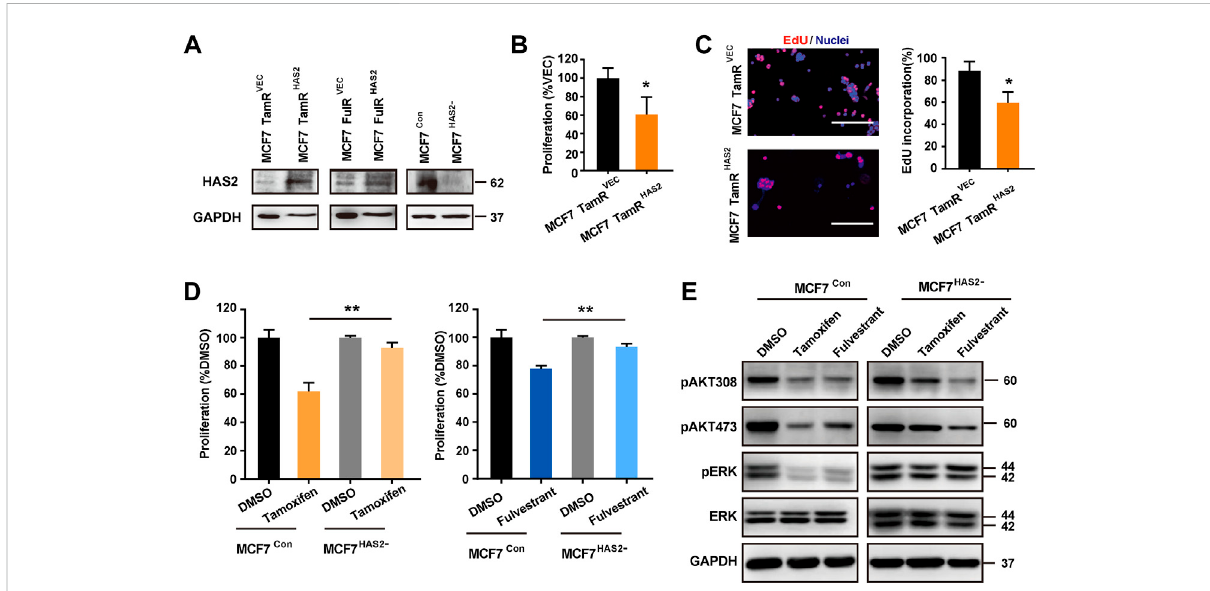
FIGURE 2 HAS2 regulated the sensitivity of ER + breast cancer cells to antiestrogens. (A) Immunoblotting analysis of HAS2 expression in endocrine- resistant MCF7 cells (MCF7 TamR and MCF7 FulR) with HAS2 overexpression and naïve MCF7 cells with HAS2 knockout. (B) The proliferation of MCF7 TamR cells with (MCF7 TamR HAS2 ) or without (MCF7 TamR Vec ) HAS2 overexpression was determined by CCK8 assay after being treated with tamoxifen(1 μ M)for3 days. (C) AnEdUassaywasperformedtoassessDNAsynthesis.Representativeimagesofatleastthreeexperimentswere shown. Scale bar, 200 µm. Quantitation of the EdU incorporation (%) was shown. (D) The effect of HAS2 knockout on the sensitivity of MCF7 cells to tamoxifen or fulvestrant was determined by a CCK8 kit. MCF7 Con and MCF7 HAS2- cells were treated with tamoxifen or fulvestrant (1 μ M) for 3 days.